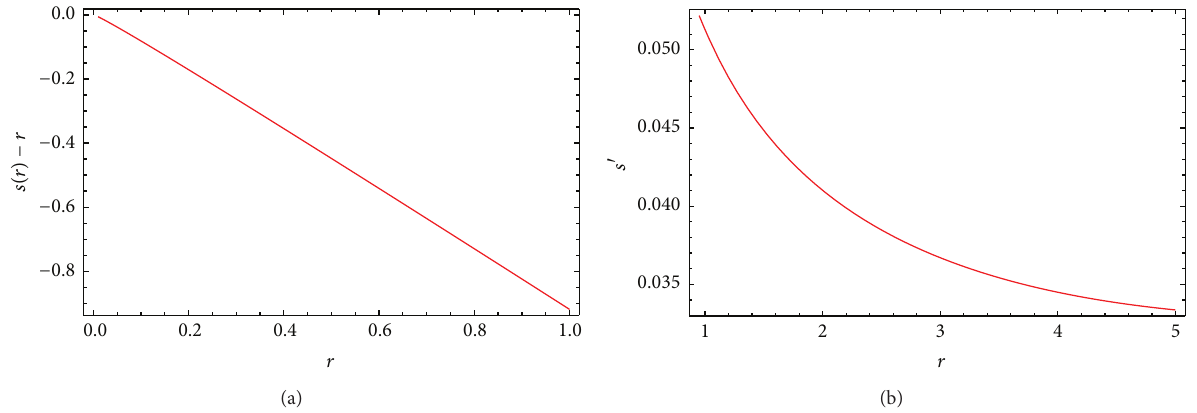
Figure 5: Plots of 𝑠(𝑟) − 𝑟 (a) and 𝑠 󸀠 (b) versus 𝑟 for logarithmic